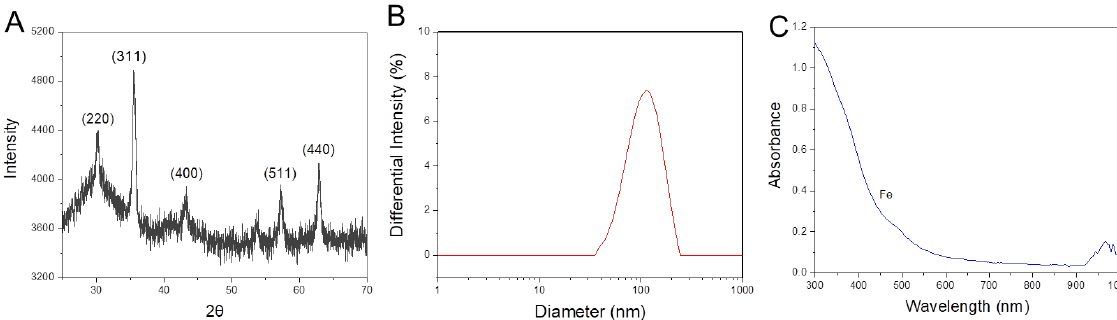
Figure 3. ( A ) XRD spectrum, ( B ) size distribution, and ( C ) absorbance spectrum of the prepared MgIONPs@TMAH.